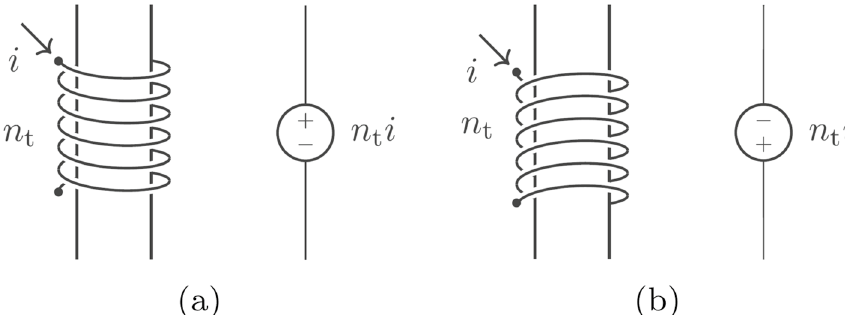
Fig. 7 Sign convention of magnetic voltage generators. a Coil wound counter-clockwise. b Coil wound clockwise. The figure is taken from